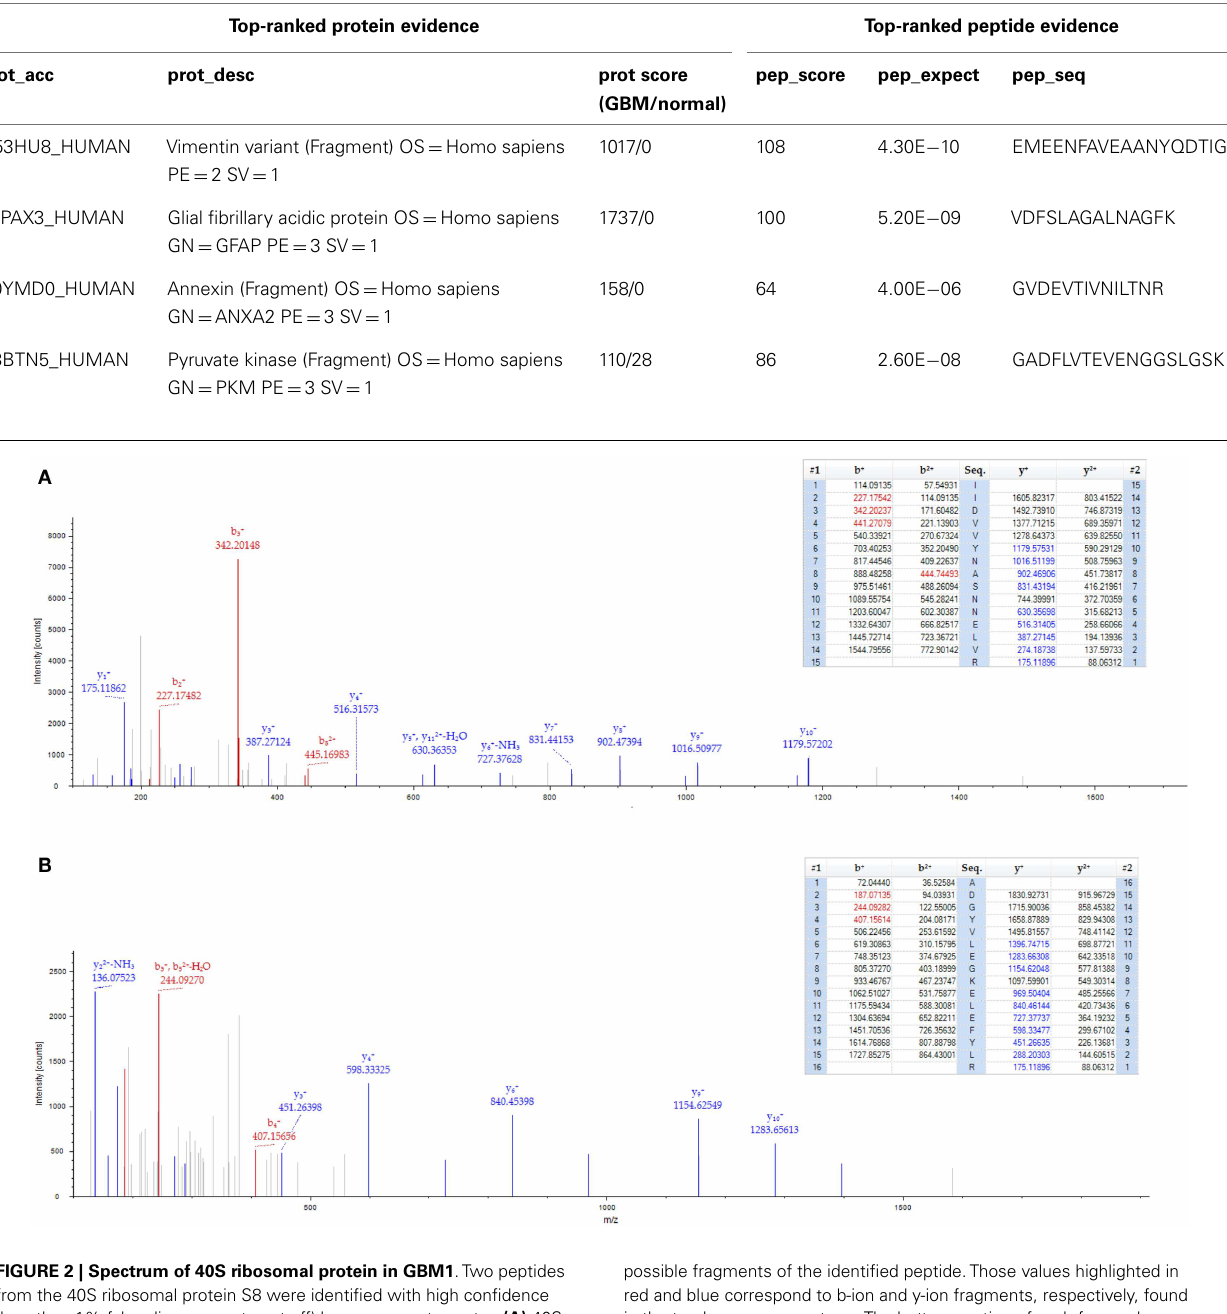
possible fragments of the identified peptide.Those values highlighted in red and blue correspond to b-ion and y-ion fragments, respectively, found in the tandem mass spectrum.The bottom portion of each frame shows the tandem mass spectrum for each identified peptide. Red and blue colored peaks correspond to predicted b- and y-ions that were identified in the